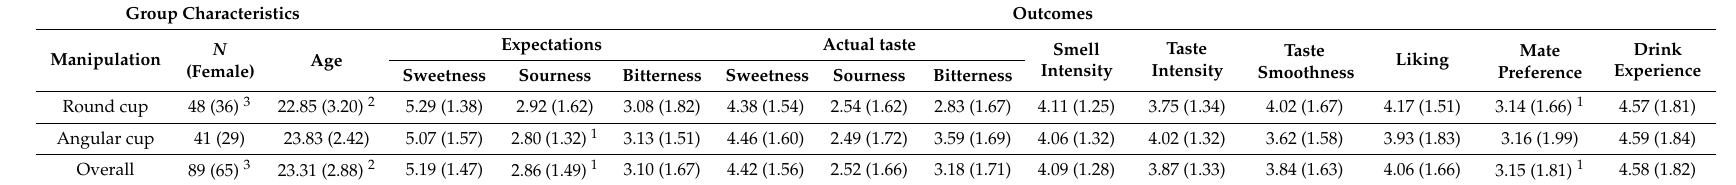
Table 2. Age and gender distributions across groups, and means (standard deviations) for all dependent variables (Study 2). Group